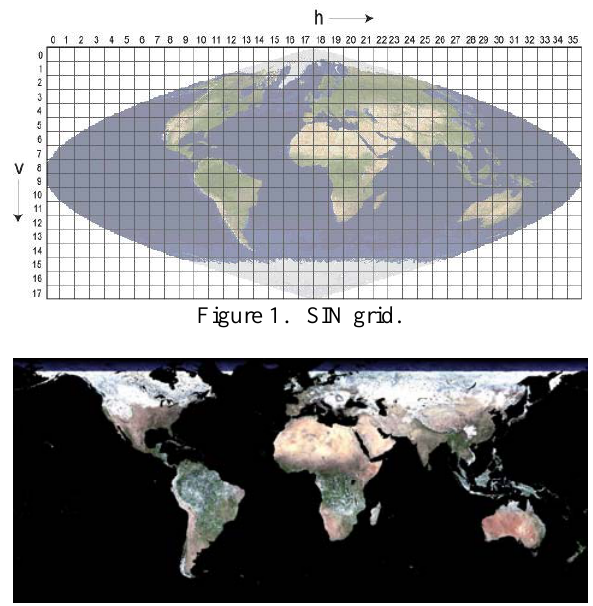
Figure 2. A result of mosaic and geometric transform. ( the scene of